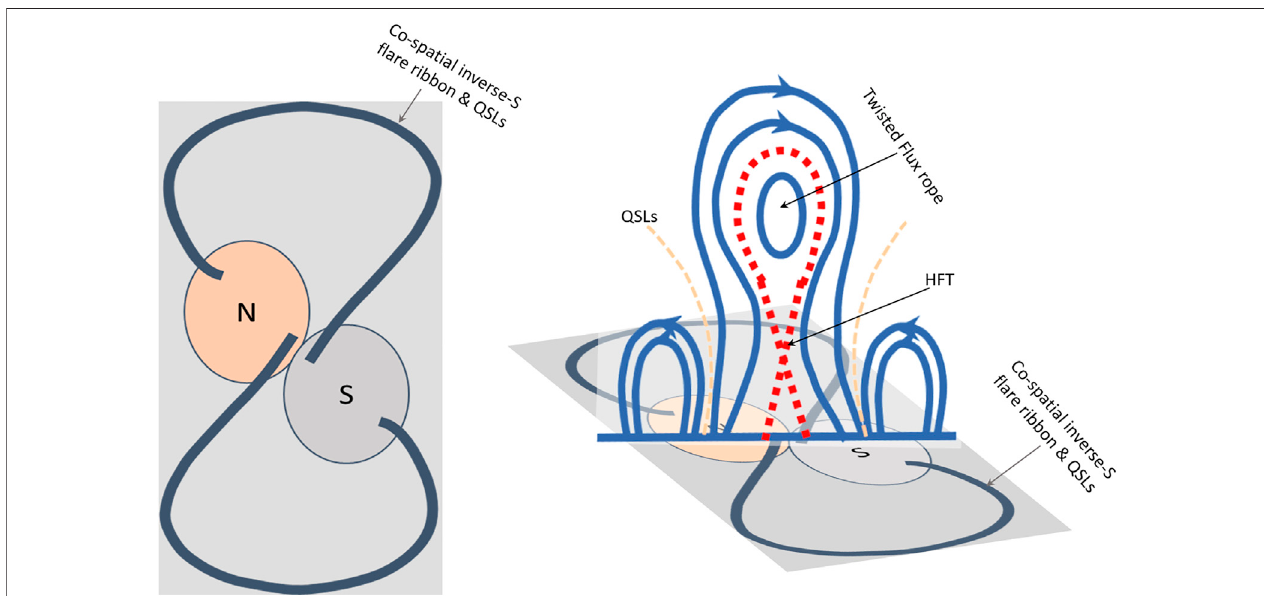
FIGURE 1 | Schematic of the 3D standard model for eruptive fl ares. left panel: Black thick curves indicate the inverse-S QSL footprints at the photosphere. “ N ” ( “ S ” )referstonorth(south)polaritymagnetic fl uxdistribution.Theseinverse-SQSLsareregardedasthecombinationoftwoinverse-Jshapedsectionswithstraightparts lying in the opposite polarities about the PIL. right panel: Perspective view of the erupting fl ux rope structure and HFT underneath in a vertical plane across the MFR. Erupting MFRs form fl are ribbons which trace these photospheric QSL footpoints.